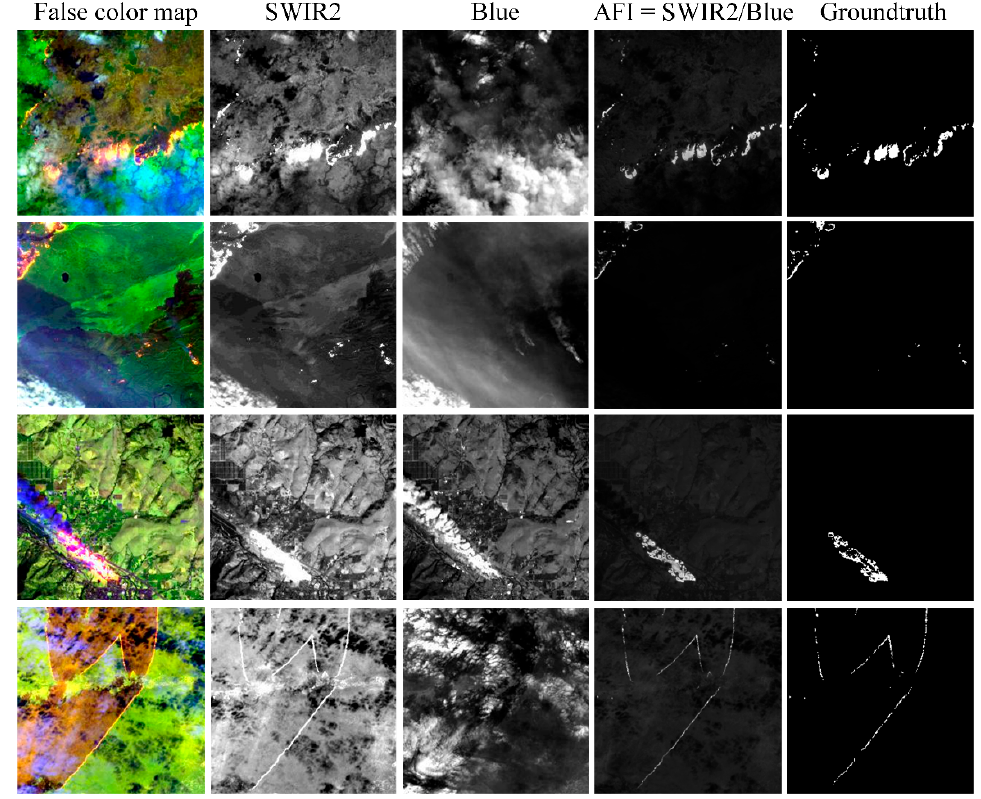
Figure 3. AFI maps from several Landsat-8 images. Each row illustrates a sample image in the dataset.